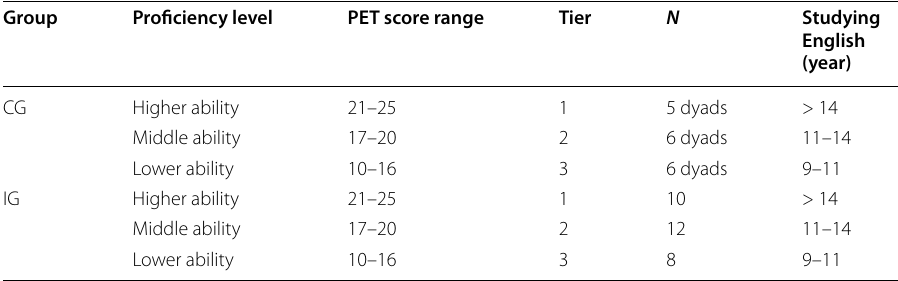
Table 2 Demographic information of the participants